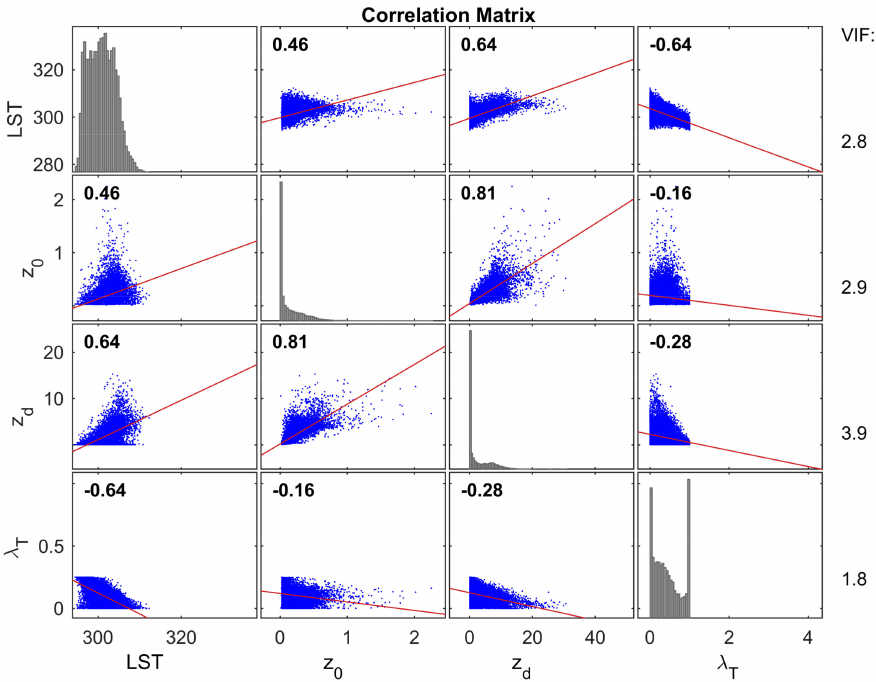
Figure A1. Correlation matrix and VIF analysis for the group Morphology at a resolution of 200 m.